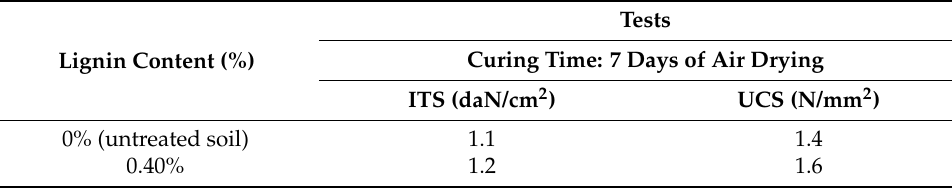
Table 4. Effect of lignin content on ITS and UCS values.